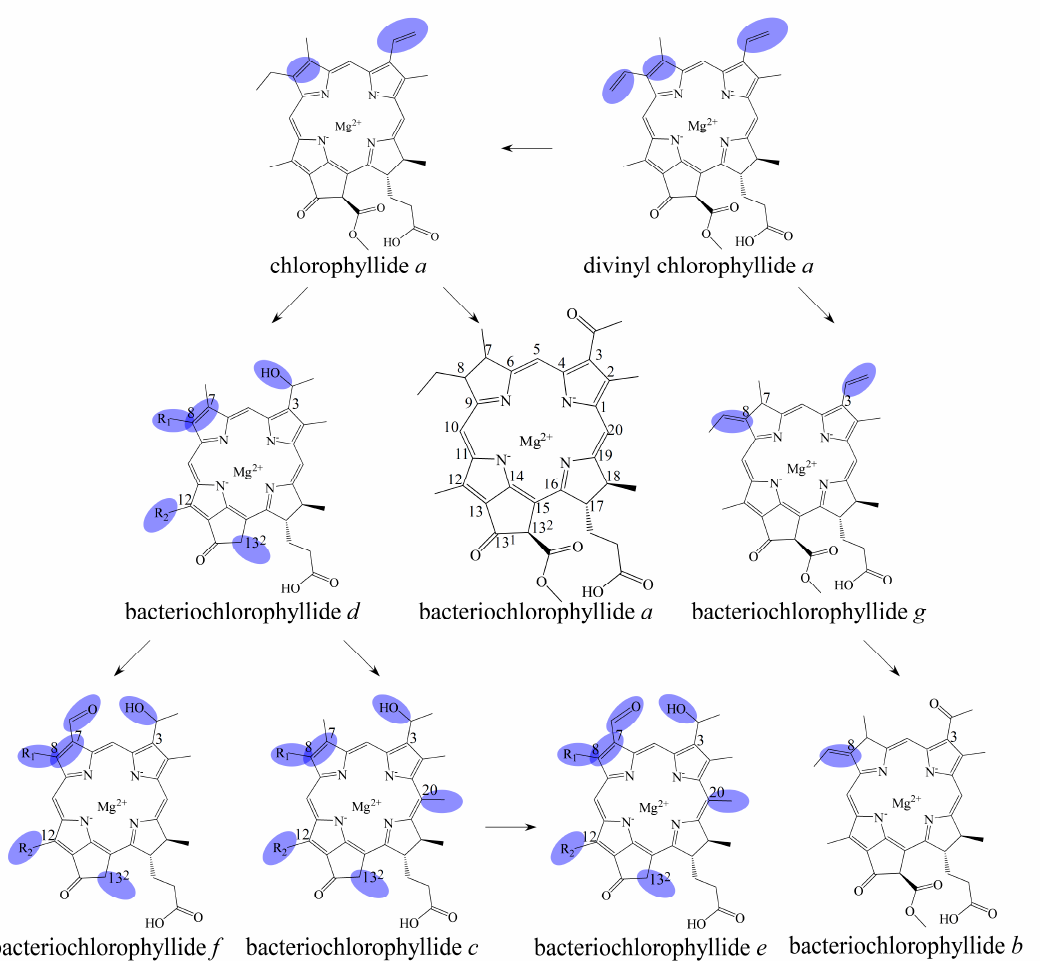
Figure 3. Biosynthetic routes among various bacteriochlorophyllides. The structure differences of bacteriochlorophyllide derivatives to bacteriochlorophyllide a were highlighted with spots.